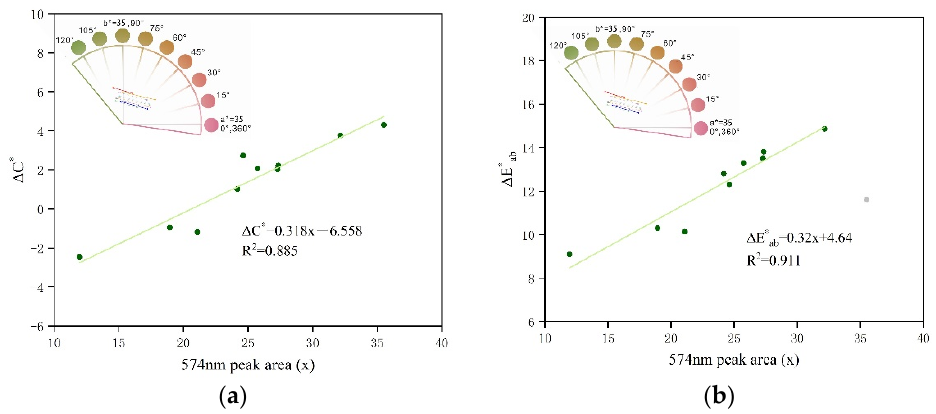
Figure 12. Chroma difference Δ C* ( a ) and colour difference Δ E* ab ( b ) are positively correlated with the area of the absorption peak at 574 nm.